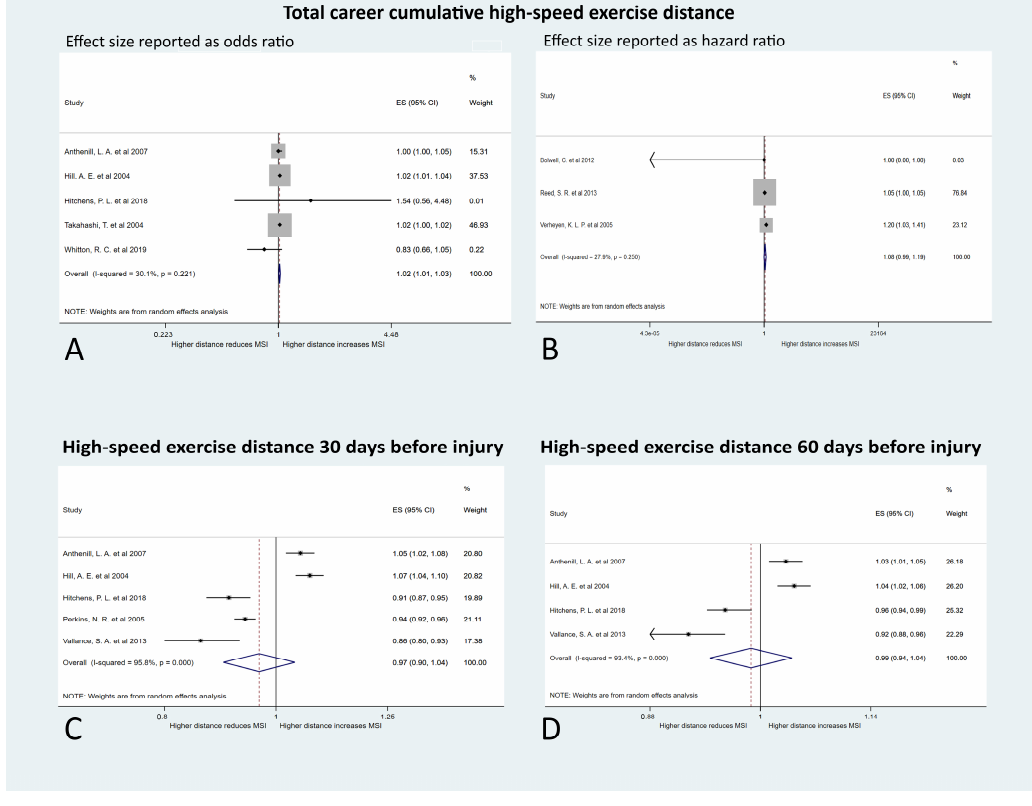
Figure 4. Forest plots of the effect of measures of cumulative high-speed exercise (HSE) distance on musculoskeletal injuries (MSI) in Thoroughbred racehorses ( A ). Total career cumulative HSE distance with effect size (ES) reported as odds per increase of 5 furlongs (1 km) of HSE history ( B ). Total career cumulative HSE distance with ES reported as hazard per increase of 5 furlongs (1 km) of HSE history ( C ). HSE distance in the 30 days before MSI occurred with ES reported as odds per increase of 1 furlong (200 m) of HSE history ( D ). HSE distance in the 60 days before MSI occurred with ES reported as odds per increase of 1 furlong (200 m) of HSE history.